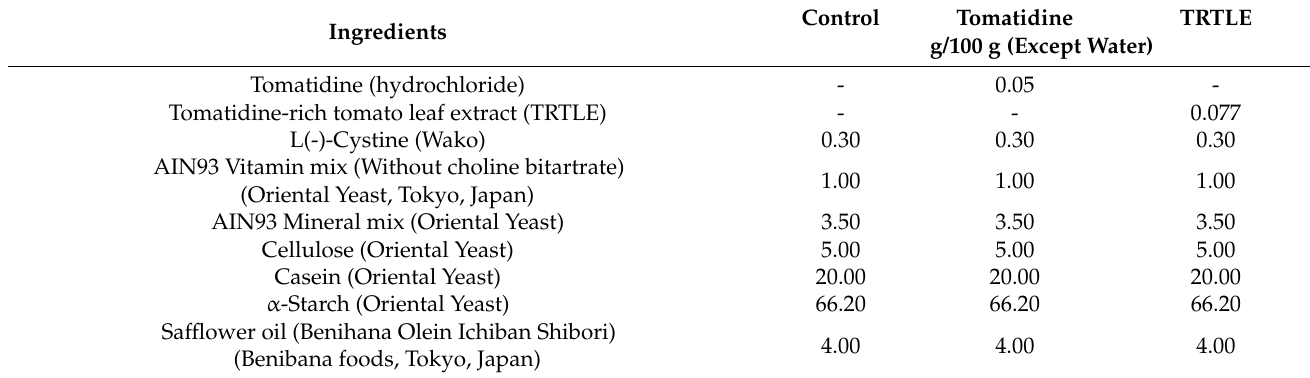
Table 2. Composition of the diet containing tomatidine or tomatidine-rich tomato leaf extract (TRTLE).